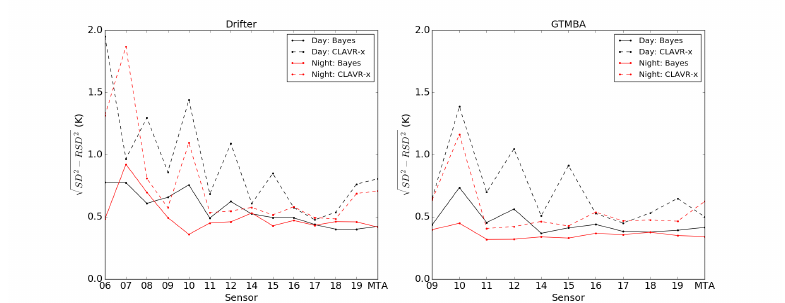
√ SD 2 − RSD 2 as a function of AVHRR sensor, as a measure of uncertainty arising from Figure 5. outliers. SST difference statistics are derived with reference to drifting buoys ( left ) and GTMBA data ( right ). Each plot shows day and nighttime retrieval statistics for the Bayesian and CLAVR-x cloud masks.